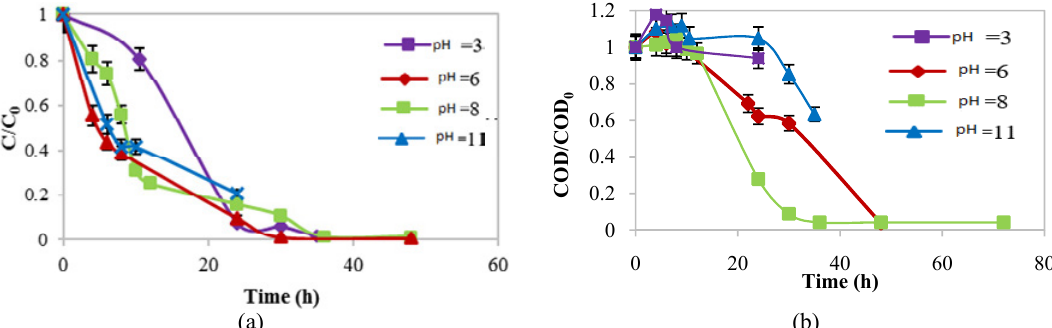
Fig. 3. (a) SDBS concentration to initial SDBS concentration ratio) vs. time in various initial pH levels (b) COD/COD 0 vs. time in various initial pH levels ([TiO 2 ] = 0.5 mg/L, [SDBS] = 300 mg/L)